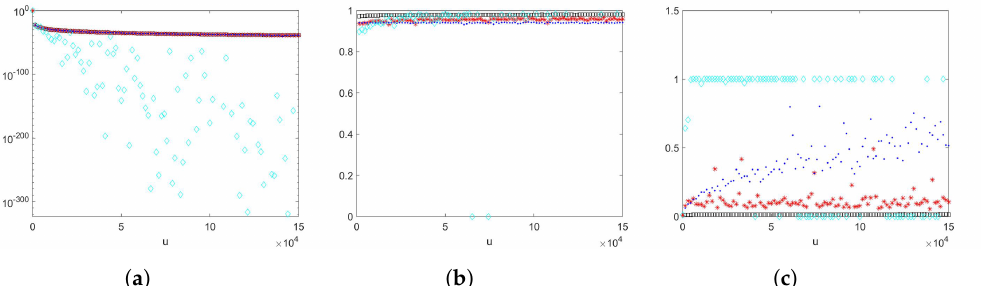
Figure 6. The random variable N is geometrically distributed with success probability p = 0.2, W i i.i.d ∼ Pareto ( 8 ) , X i i.i.d ∼ Erlang ( 2,3 ) , where i = 1, . . . , N . Black squares: ConAK1+IS+CV (condition- ing and IS on Pareto). Red stars: ConAK2+CV (conditioning on Erlang). Blue dots: ConAK2+IS+CV (conditioning and IS on Erlang using an exponential PDF). Cyan diamonds: ConAK2+IS+CV (condi- tioning and IS on Erlang using an Erlang PDF). ( a ) Estimates of (cid:96) ( u ) as a function of u on a logarithmic scale. ( b ) Empirical logarithmic rates as a function of u . ( c ) Empirical relative errors as a function of u